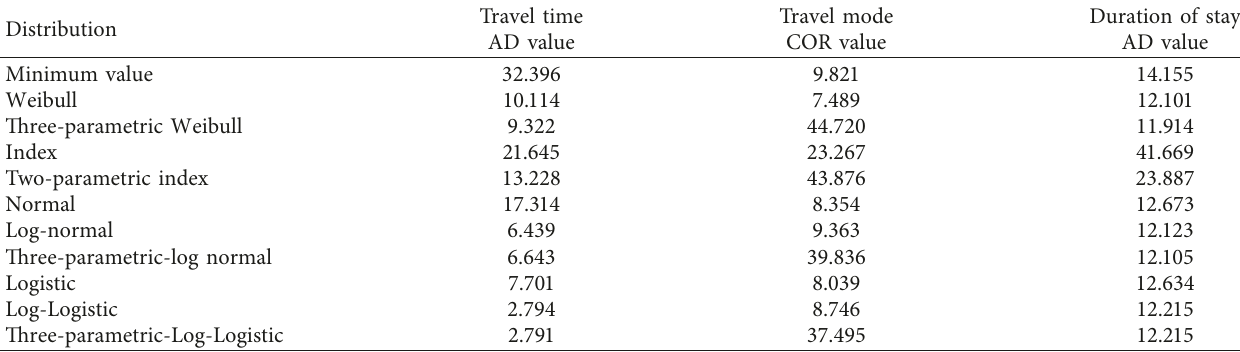
Table 5: AD value of different